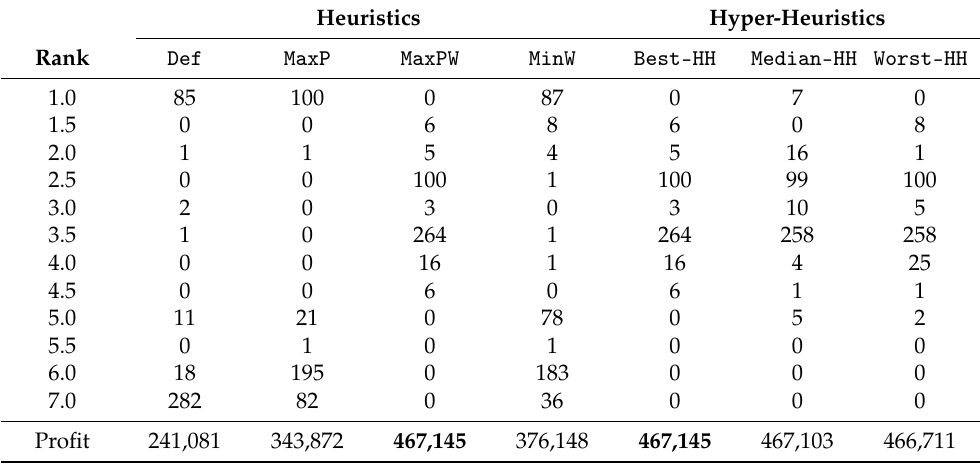
Table 4. Ranks and total profit obtained by the four heuristics and the best, median, and worst hyper-heuristics trained on set α 1 and tested on set α 2 . The best result, measured in terms of total profit, is highlighted in bold. Heuristics